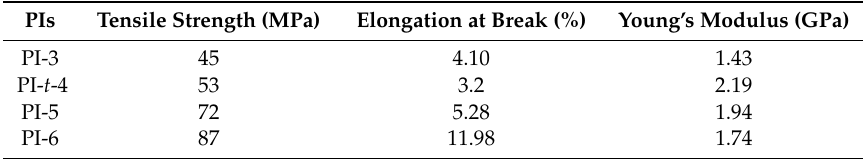
Table 4. Mechanical properties of